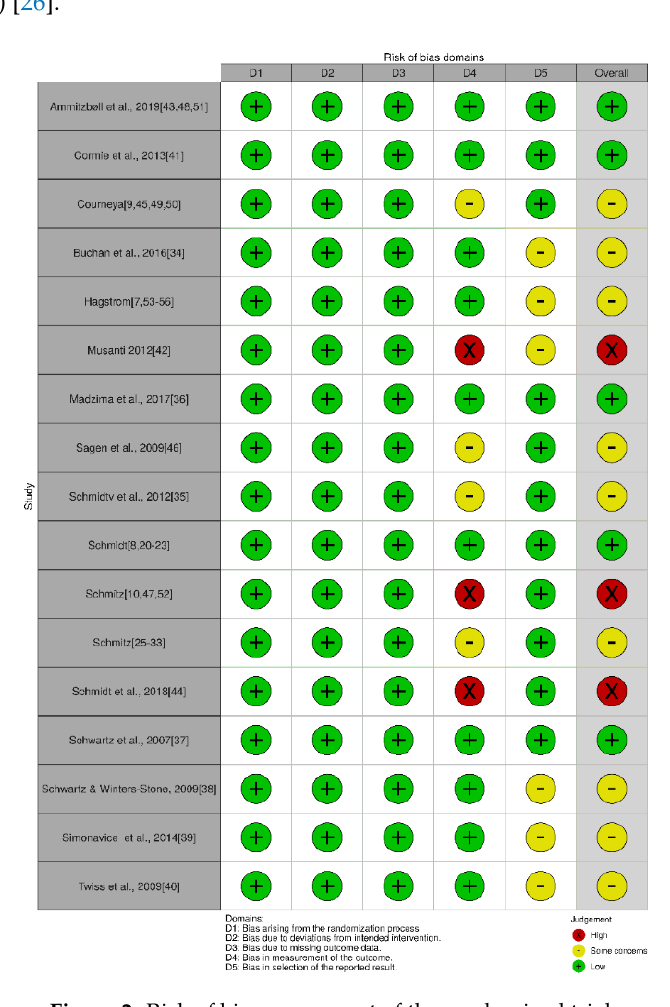
Figure 2. Risk of bias assessment of the randomized trials.